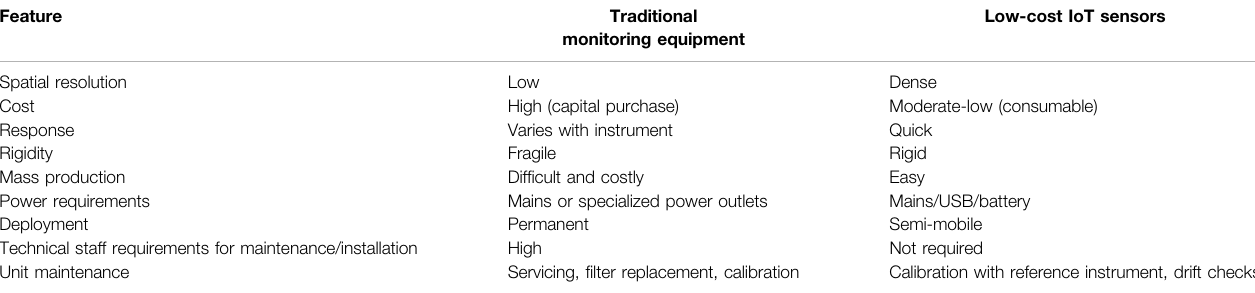
TABLE 1 | Comparison of low-cost sensors vs . traditional monitoring [edited from Kularatna and Sudantha (2008)].